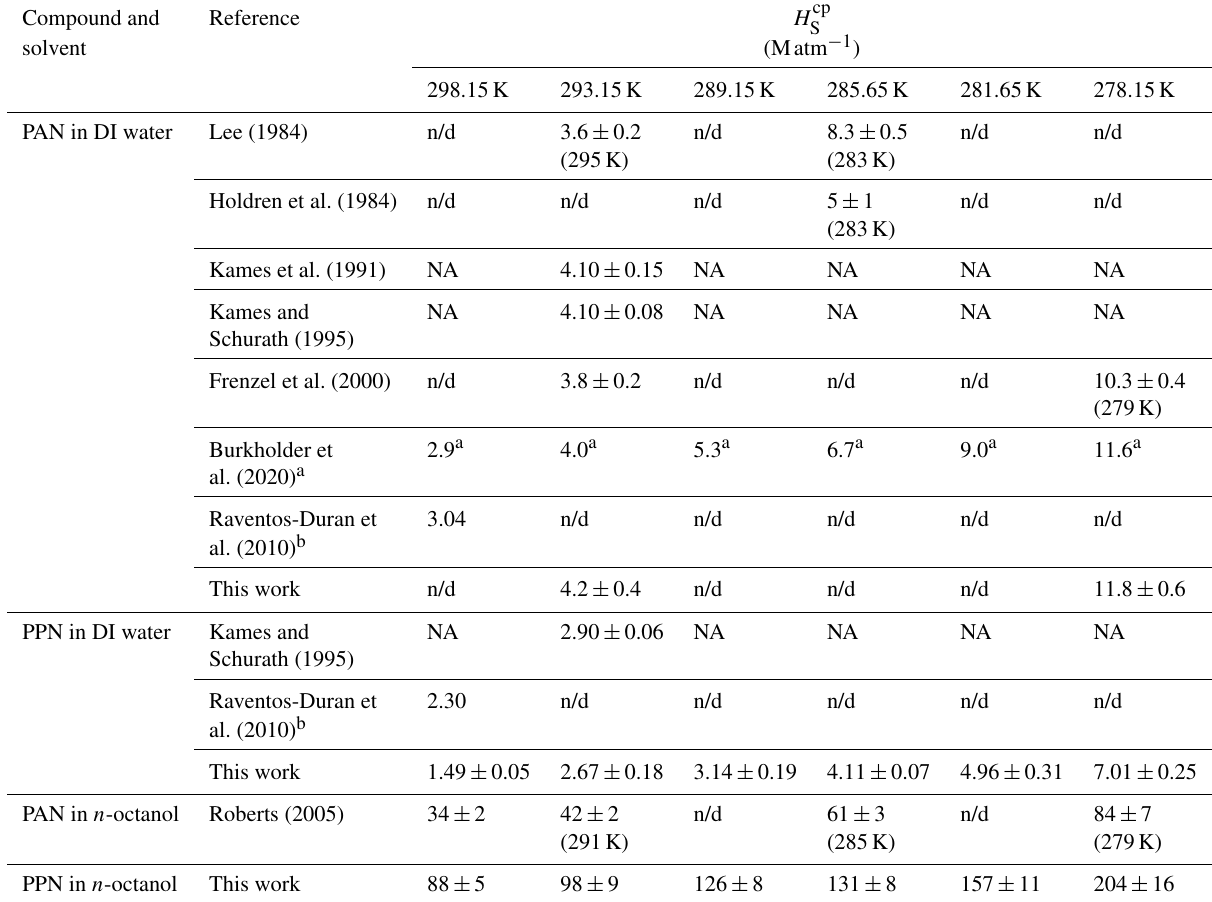
Table 1. Summary of Henry’s law solubility constants. Compound and